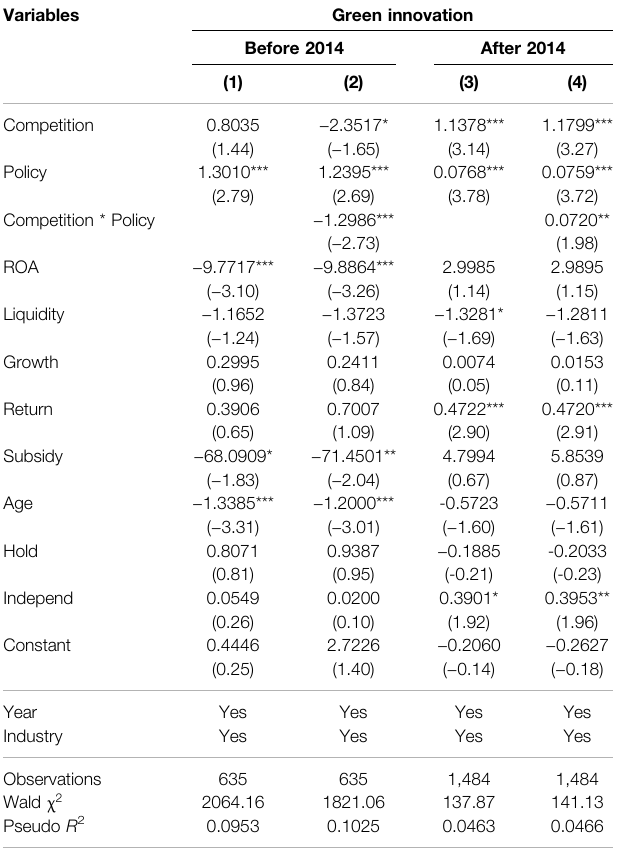
TABLE 6 | Results of different